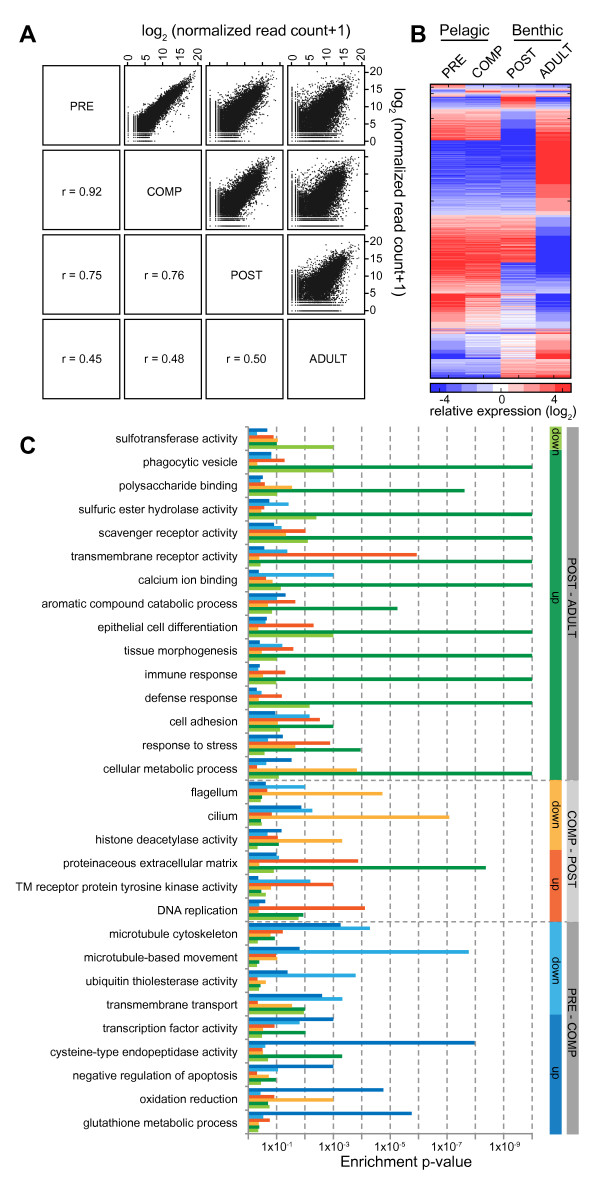
Transcriptome profile of the developing sponge. (A) Correlation of expression for 13,503 genes detected above the cutoff threshold across different stages of development (r, Pearson correlation coefficient). The x and y axes are log2 of read counts +1 normalized to the total number of mapped reads. (B) Expression profile for genes that are differentially expressed during development. Data for 4,677 genes with greater than four-fold change in expression in one stage compared to the other three stages is shown (p < 0.05, two-tailed t-test). Each row represents data for one gene. Pelagic stages include precompetent (PRE) and competent (COMP) larvae; benthic stages include postlarvae (POST) and adult (ADULT). (C) Gene ontology (GO) analysis for gene groups up- or downregulated by greater than four-fold between successive stages. Enrichment p-values for selected terms are shown. GO terms are grouped by stage transition (indicated by gray bars to the right) while colored bars indicate the direction of change (up or downregulation) at each transition.